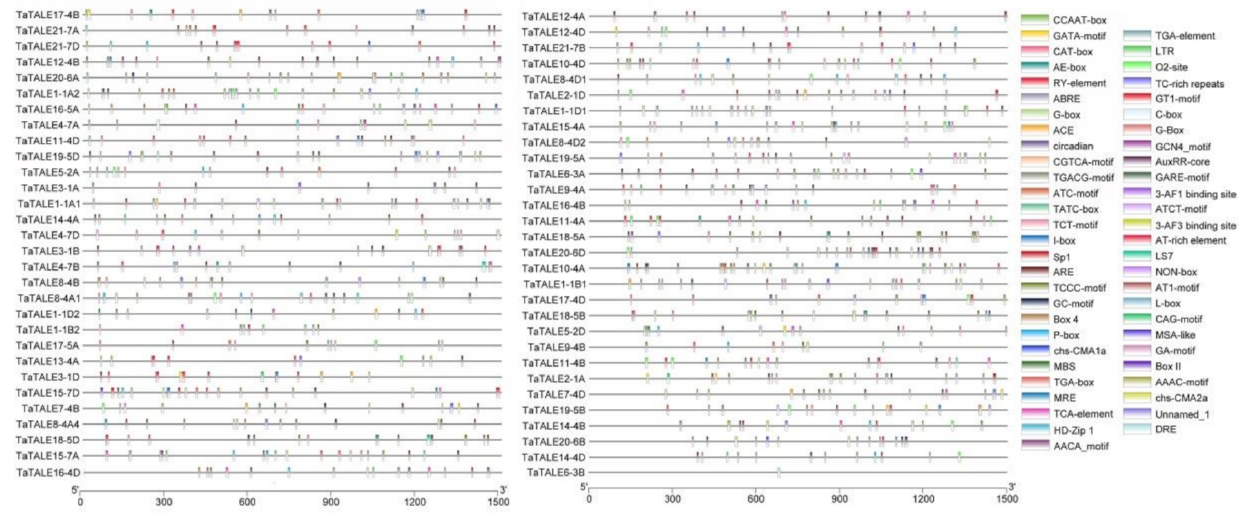
Figure 4. Promoter analysis TaTALE genes of bread wheat. TBTool was used to show the cis -regulatory elements represented with different